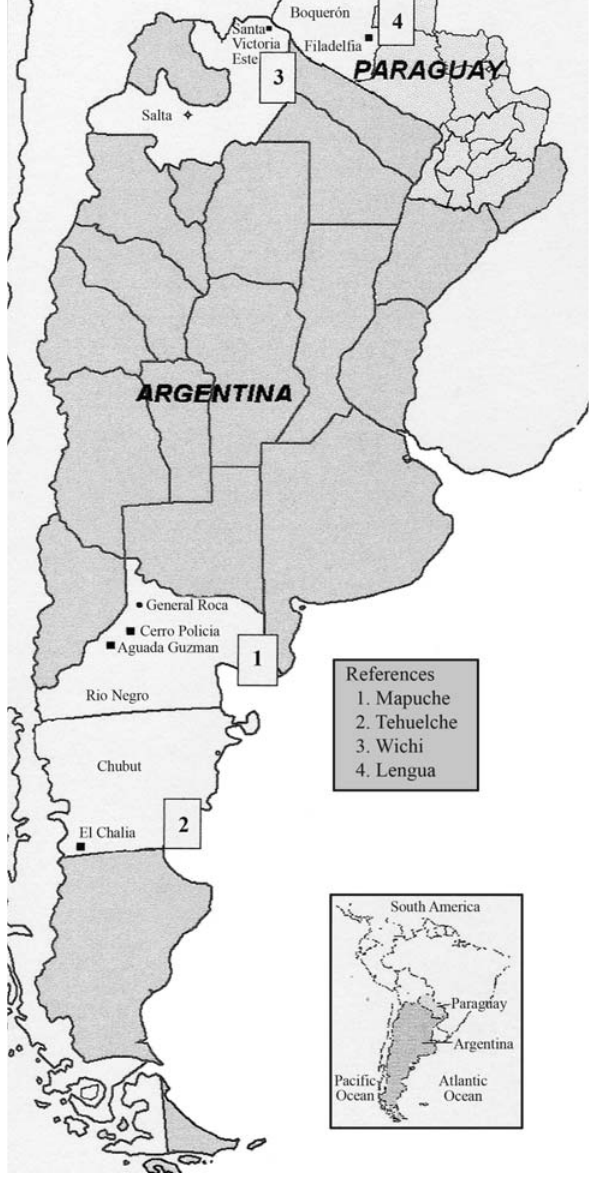
Figure 1 - Map of Argentina and Paraguay showing the geographic loca- tions of the Amerindian populations analysed in this